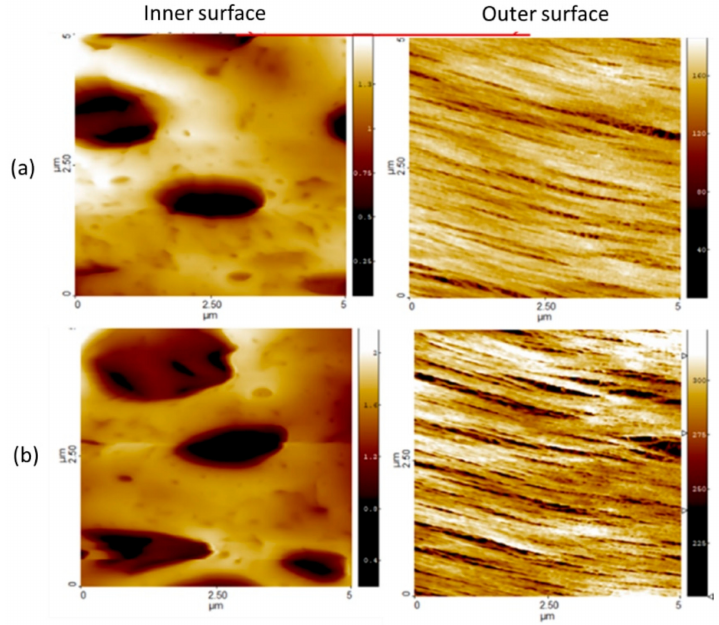
Figure 1. AFM micrographs of neat PAES hemodialysis membrane fibers collected at two different spots of closed proximity (( a ) first and ( b ) second rows).